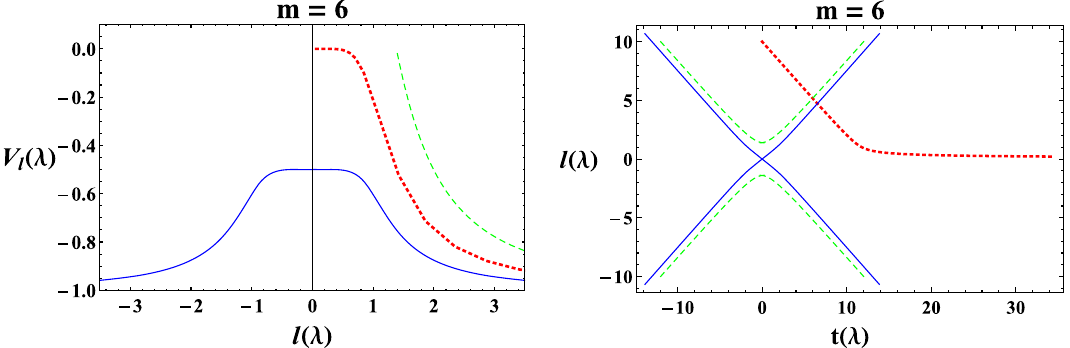
Fig. 7 Effective potential and geodesics for 4D-GEB wormhole ( m = 6): dotted-red, dashed-green, and continuous-blue curves representing – Trapped, Returning and Crossing geodesics respectively